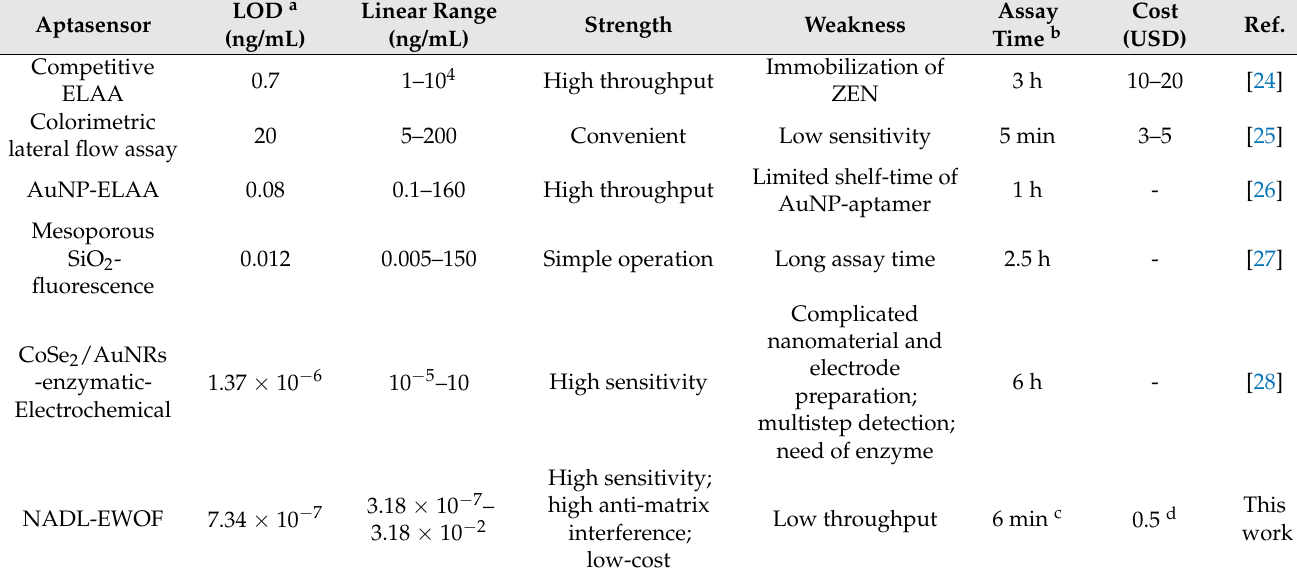
Table 1. The 8Z 31 -based aptasensors reported in recent